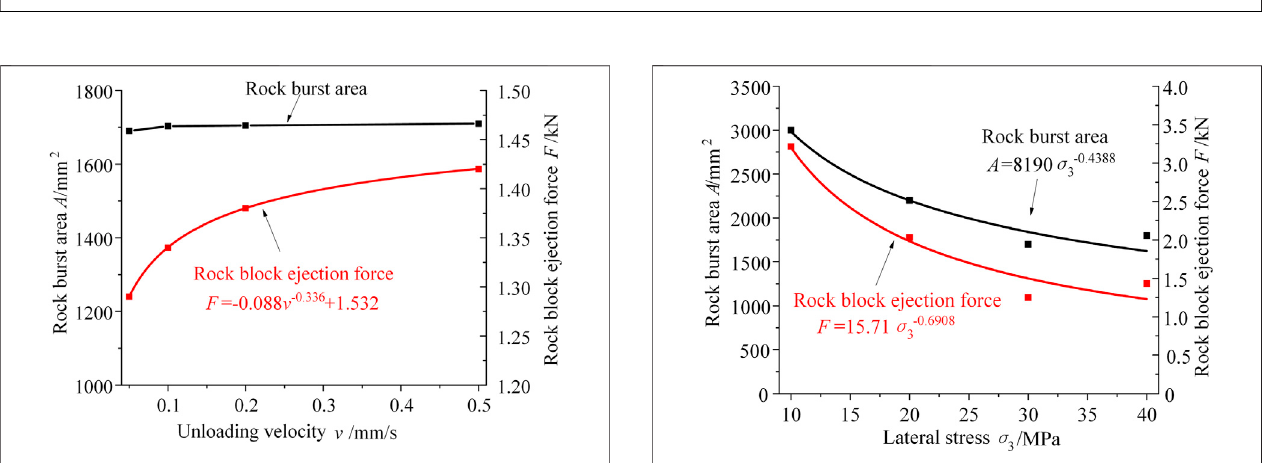
FIGURE9|(A) Velocityand (B) amountofenergyreleaseandenergydissipation,and (C) energyreleasedamountindifferentgroupsofgraniteunderdifferentaxial stress.